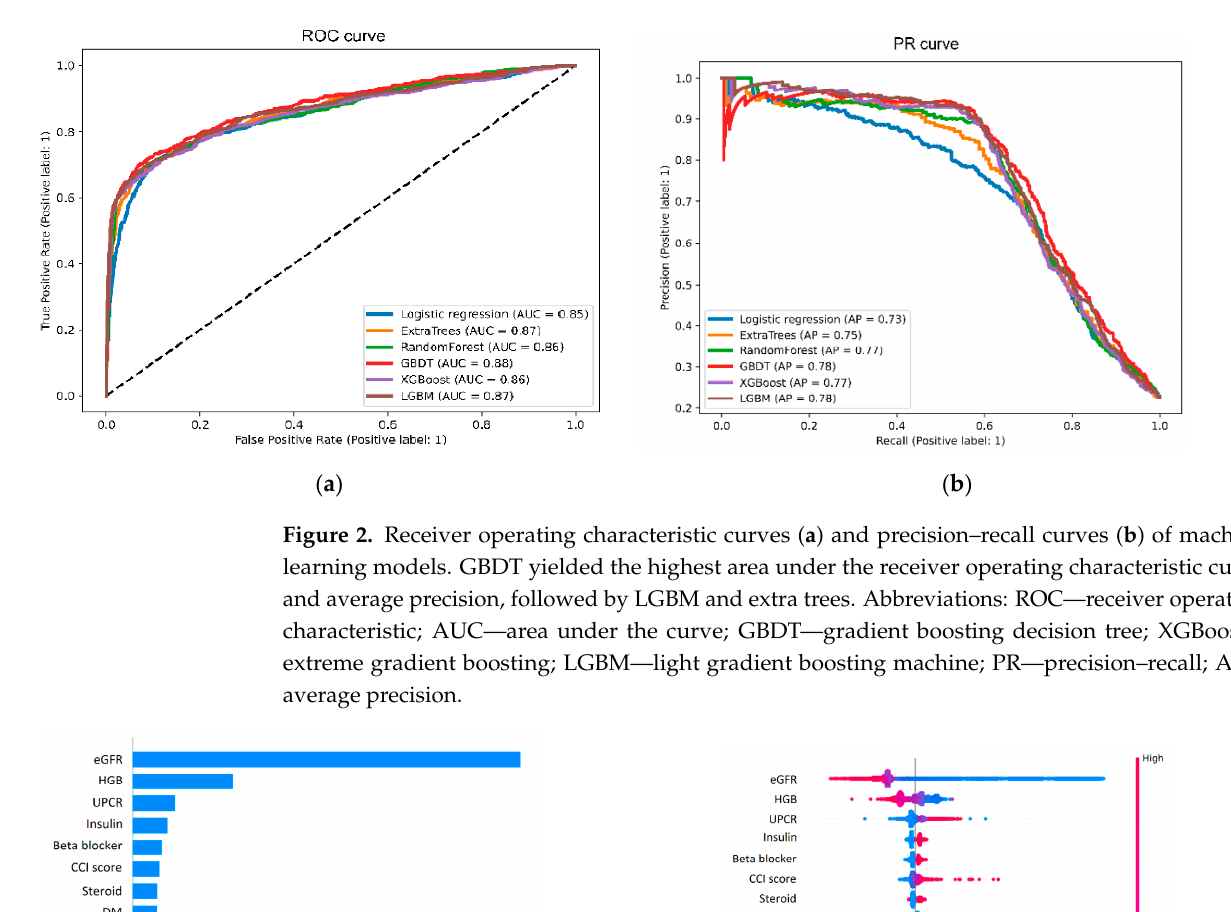
most significant impact on ESRD prediction.